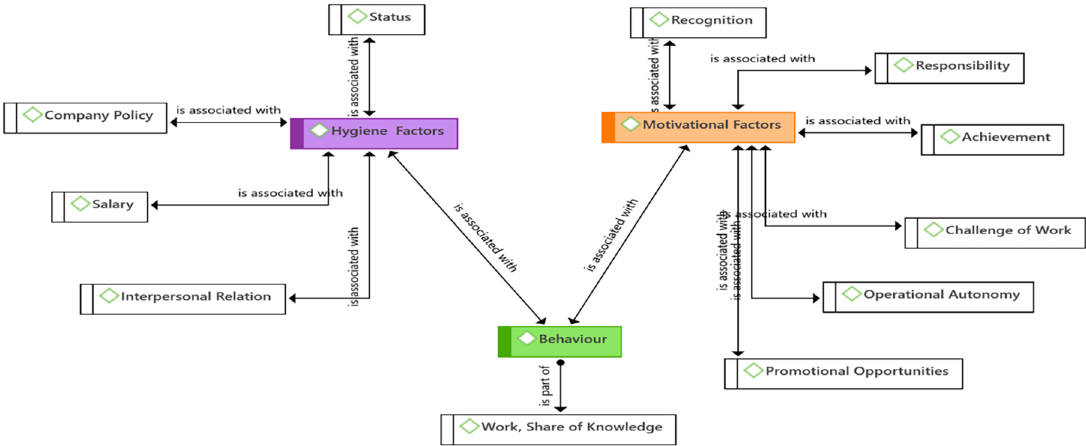
Figure 9. Herzberg’s two-factor theory modified by Hendriks